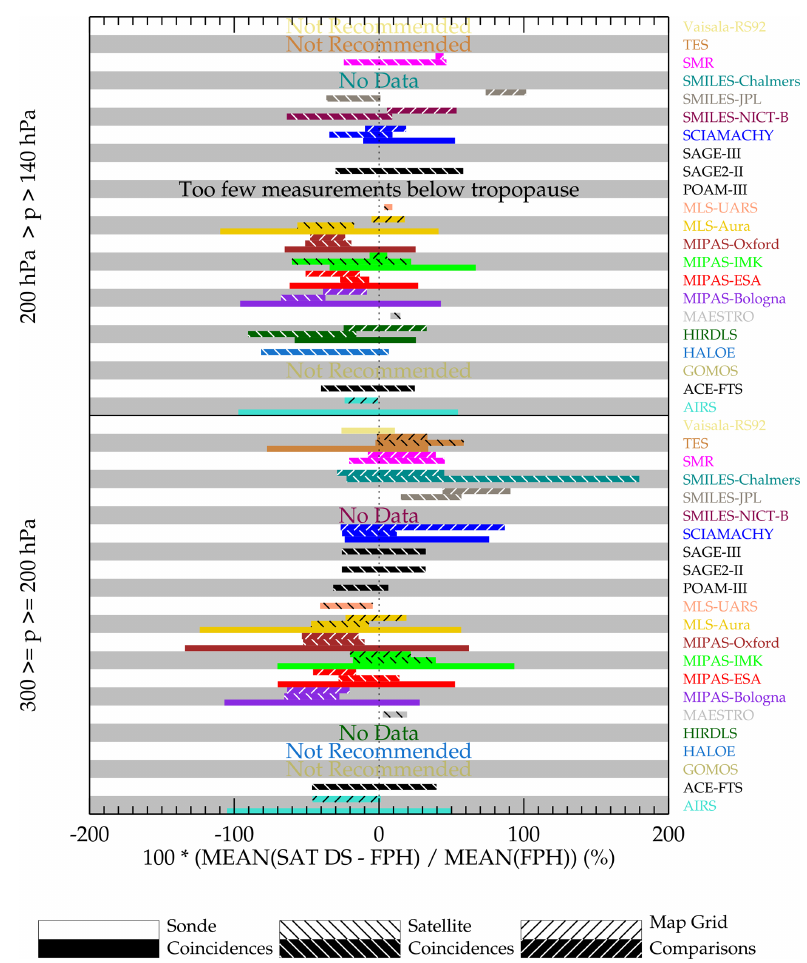
Figure 24. A summary plot of biases among the satellite and Vaisala RS92 sensor for the upper troposphere relative to BFH measurements (zero value on the x axis). The sonde coincidences have no hatching and are shown in the bottom third of the y axis band dedicated to the data set. The satellite coincidences and mapped grid comparisons have either black or white diagonal hatching, depending on the darkness of the data sets color and are shown in the middle and top third of the y axis dedicated to the data